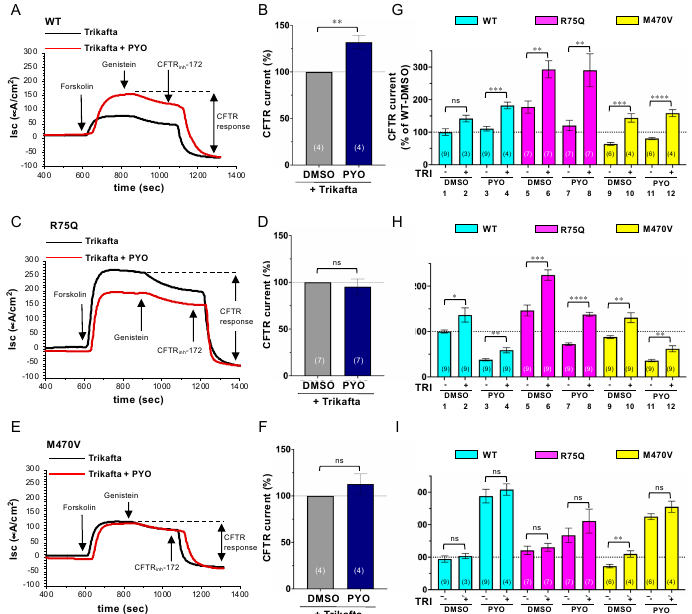
Figure 7. Trikafta corrects the PM expression and function of CFTR variants upon PYO exposure. ( A – F ) Apical CFTR current (Isc) in CFBE Tet-on cells expressing WT- ( A , B ), R75Q- ( C , D ), or M470V- CFTR ( E , F ) treated with Dox (50 ng/mL) for 3 days was measured as Figure 6. PYO (5 µ M) was treated for 2 days before Isc measurement. Trikafta (3 µ M VX-661, 3 µ M VX-445, and 1 µ M VX-770) was treated for 24 h before Isc measurement. The effect of PYO on the WT- ( B ), R75Q- ( D ), and M470V-CFTR ( F ) Isc upon Trikafta treatment was calculated and expressed as % of the Isc in each DMSO-treated cell. ( G ) The Isc of CFTR variants was compared and expressed as % of the WT- CFTR Isc in the DMSO-treated cells. The data in the cells without Trikafta (TRI) treatment shown in Figure 6G were used for comparison (odd lanes). ( H ) The PM density of CFTR variants in CFBE Tet-on cells treated under the same condition as in ( G ), except for Dox (1 µ g/mL), was measured by cell surface ELISA. ( I ) The FPMA of CFTR variants was calculated as the ratio of the Isc ( G ) to PM density ( H ) and normalized to WT-CFTR in the DMSO-treated cells. Data represent mean ± SE. The number of data from at least two independent experiments is indicated in parentheses. n.s., not significant; * p < 0.05, ** p < 0.01, *** p < 0.001, **** p < 0.0001 ( t